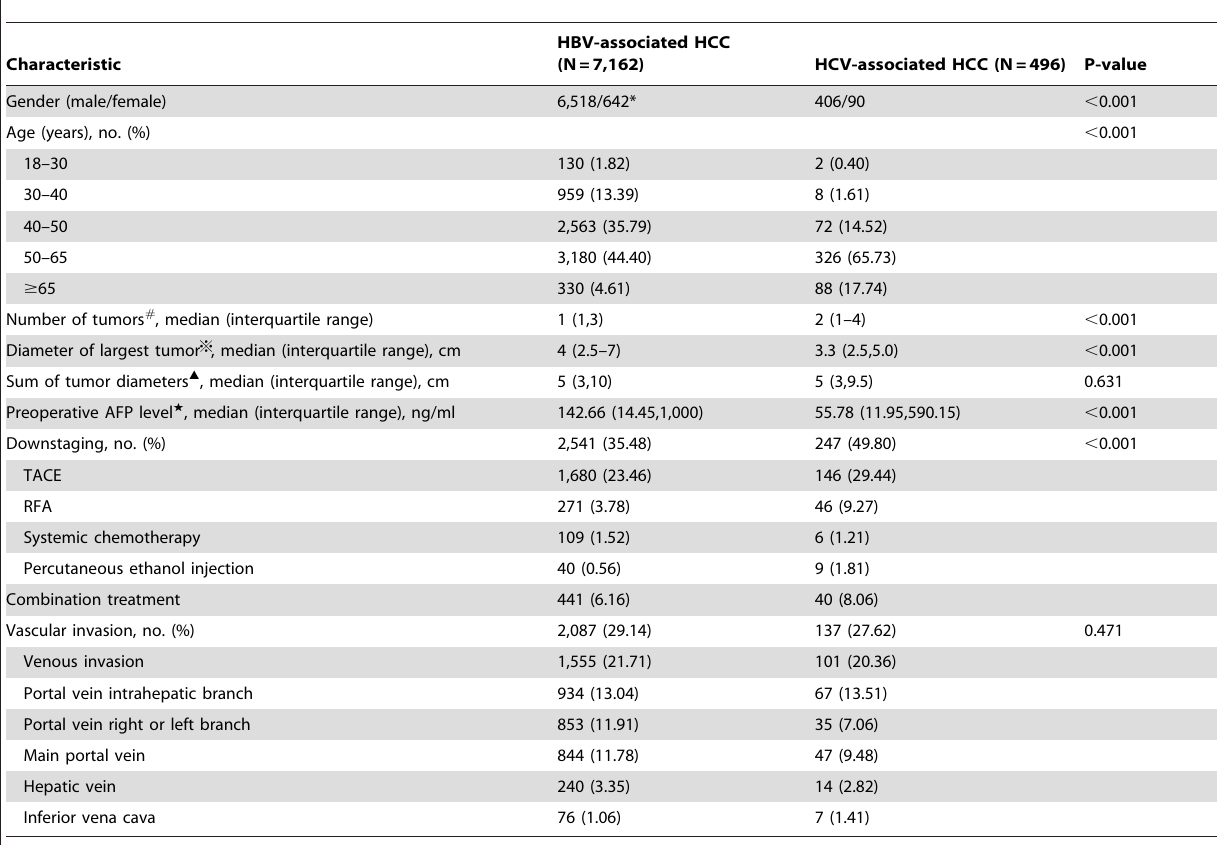
Table 1. Clinical characteristics of patients with viral hepatitis-associated HCC who underwent liver transplantation.